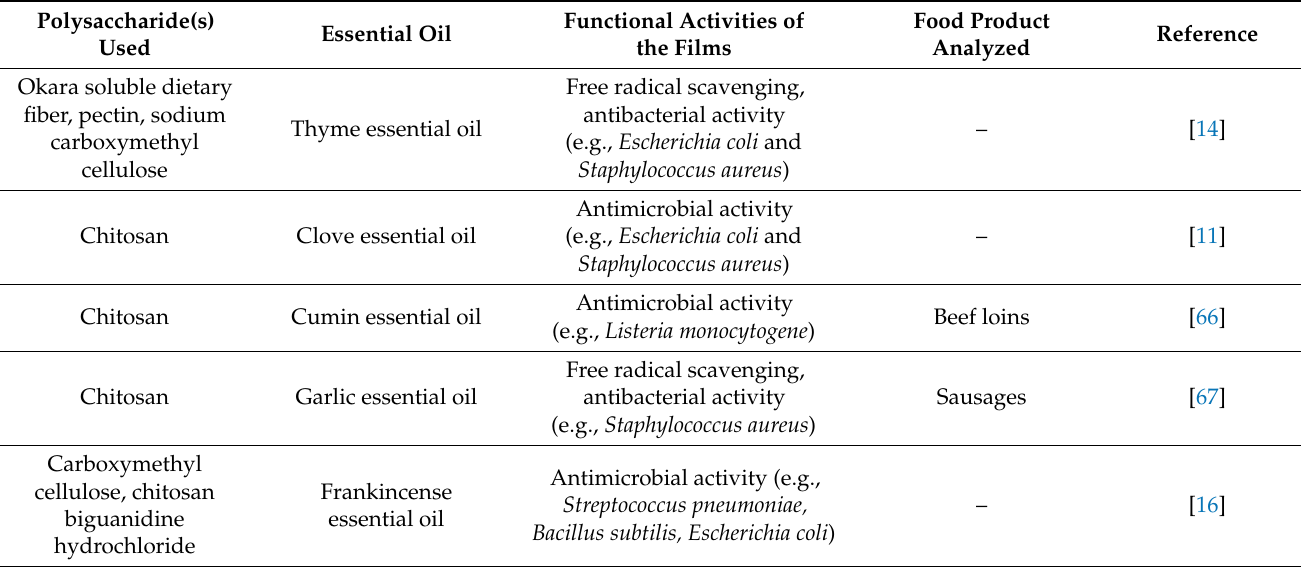
Table 2. Summary of recent studies on Essential Oil (EO)-containing packagings